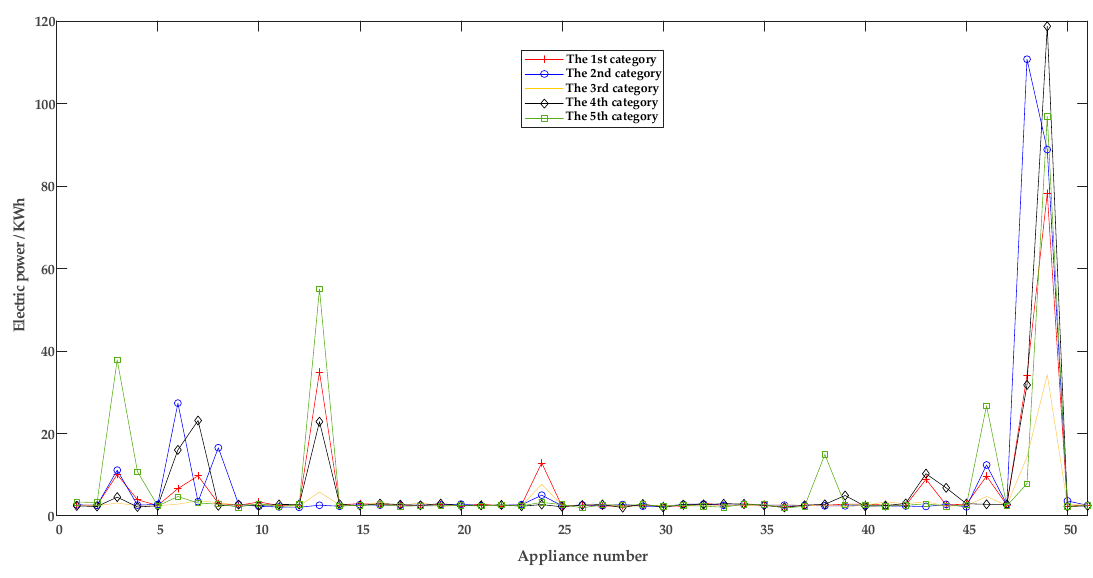
Figure 8. User clustering graph after PCA dimension reduction.